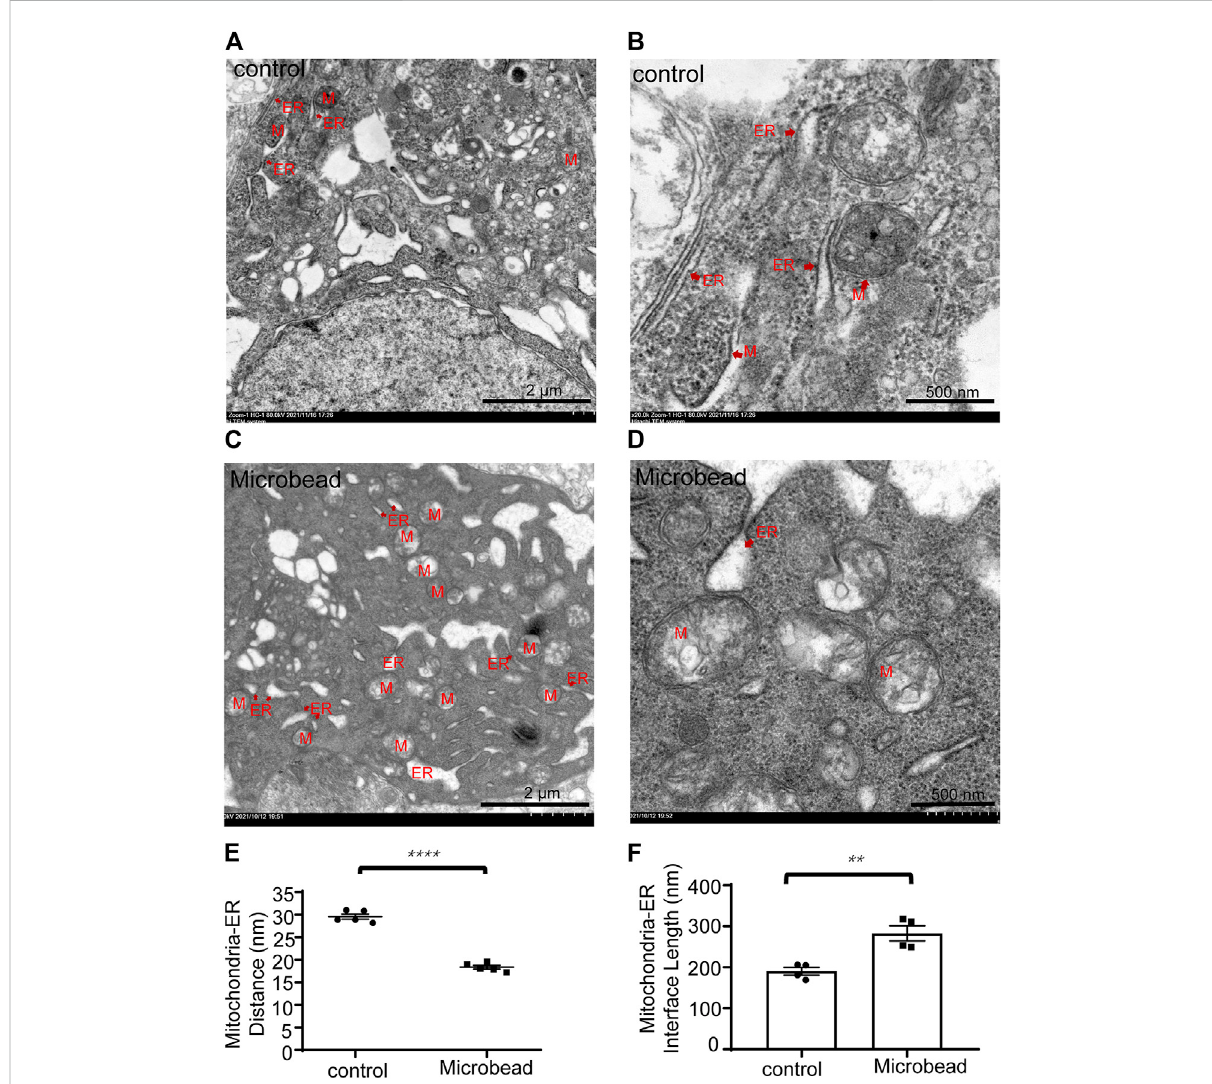
Representative TEM images of the control group (A,B) and the microbead group (C,D) . M, mitochondria, ER, endoplasmic reticulum. Scale bar in (A) and (C) , 2 µm. Scale bar in (B and D) , 500 nm. (E,F) The p -values were determined using an unpaired Student ’ s t-test for two-group comparisons. pp p < 0.01 and pppp p <